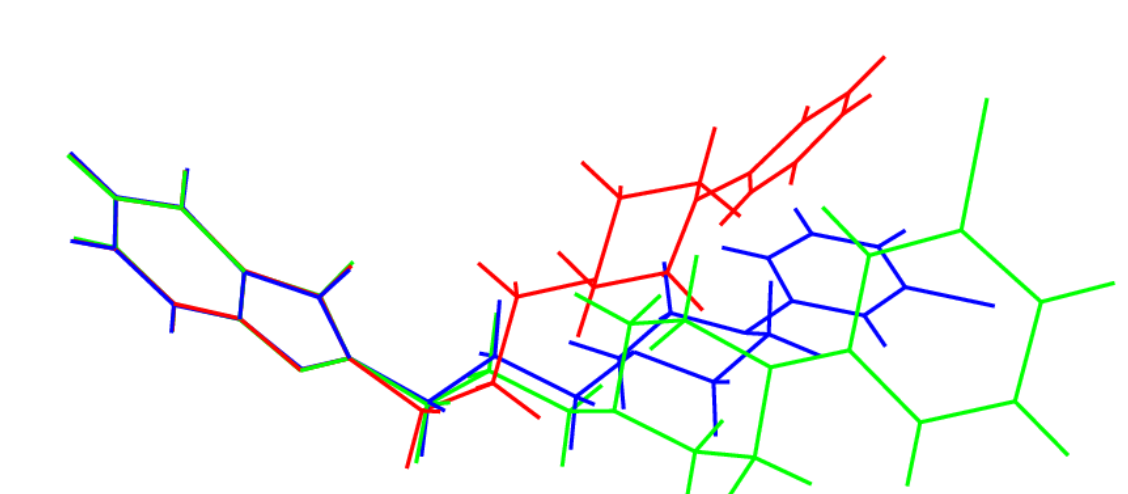
Figure 6. Overlay plot of the trazodone molecules in the α (red), β (green) and γ (blue) polymorphs with the fused ring systems superimposed.